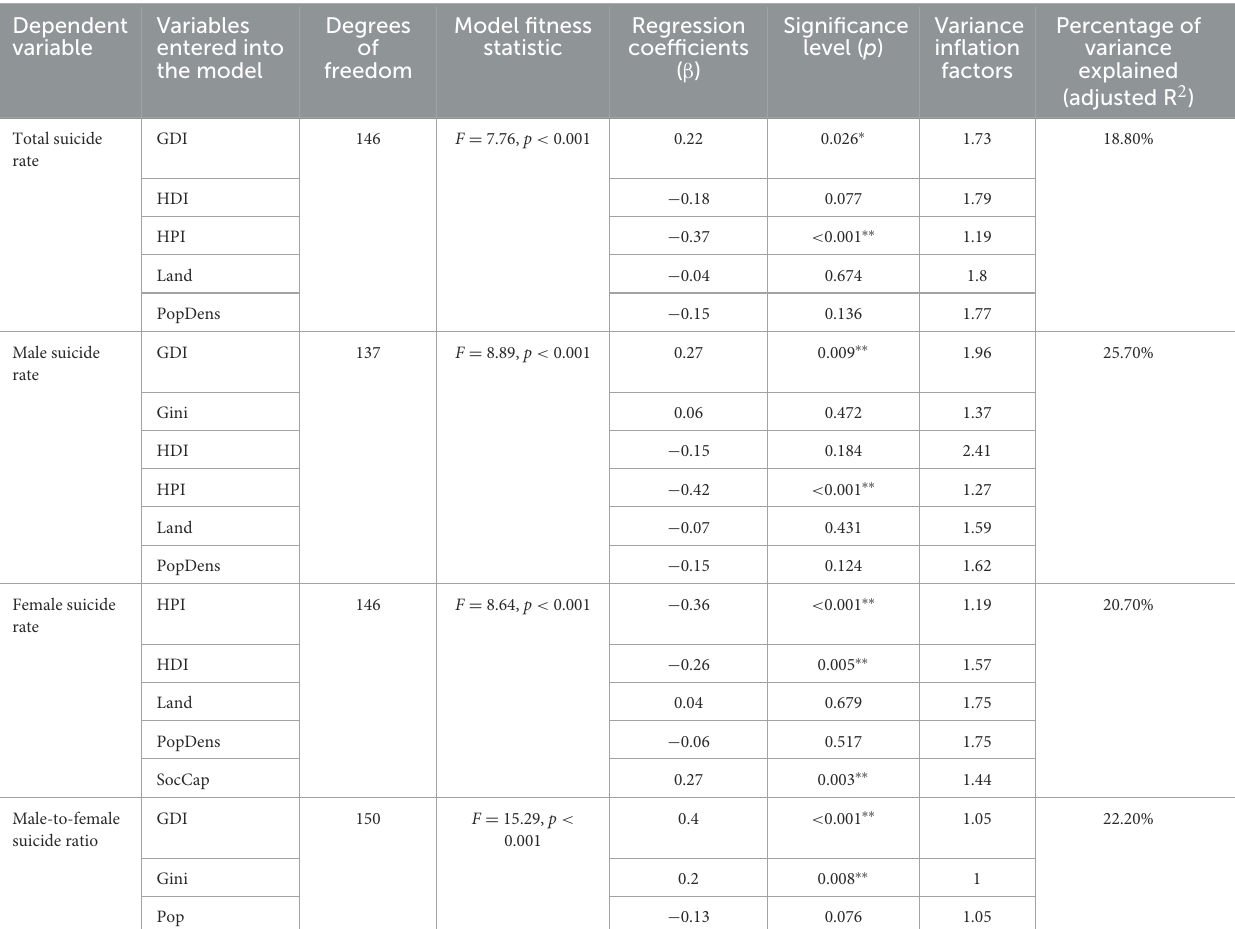
TABLE 3 Multivariate linear regression analyses of socioeconomic indices associated with national suicide rates. Dependent variable